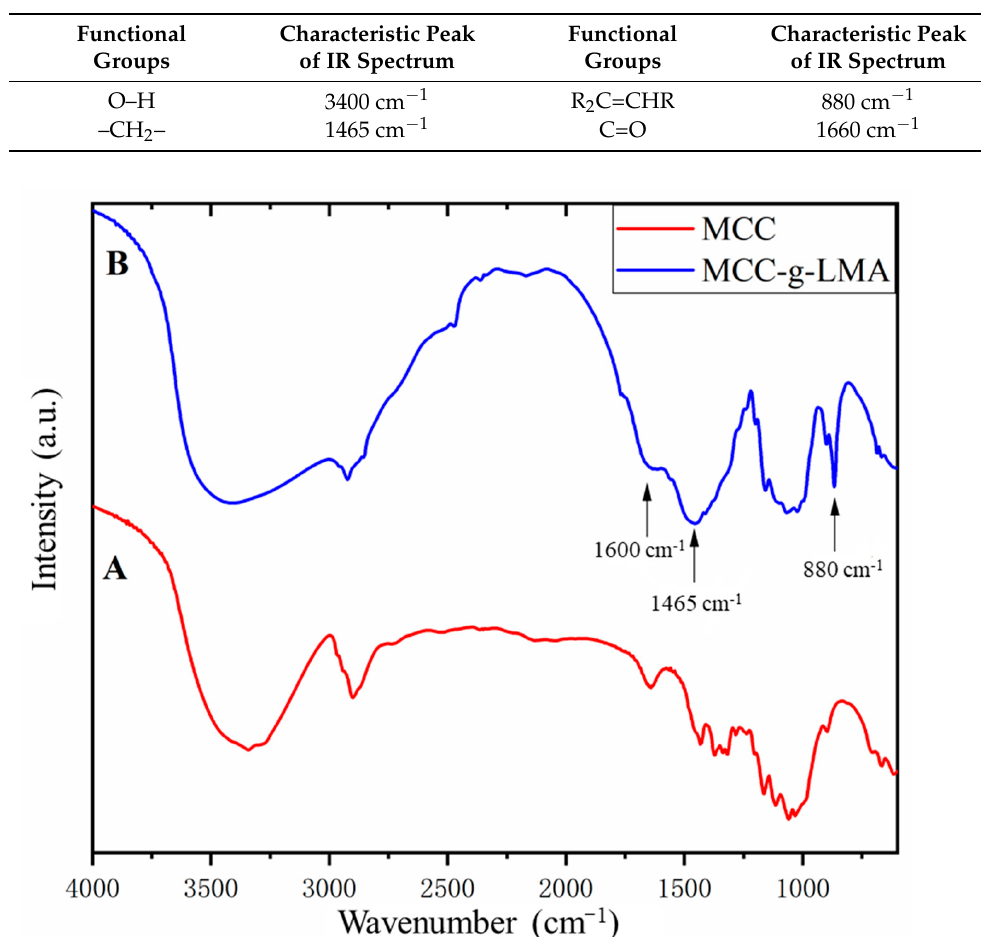
Figure 2. FTIR spectra of MCC and MCC-g-LMA. ( A ) MCC; ( B ) MCC-g-LMA. Table 1. Infrared characteristic absorption peaks of different functional groups.